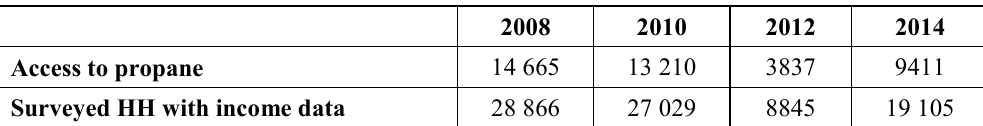
Table 7. Propane Access,